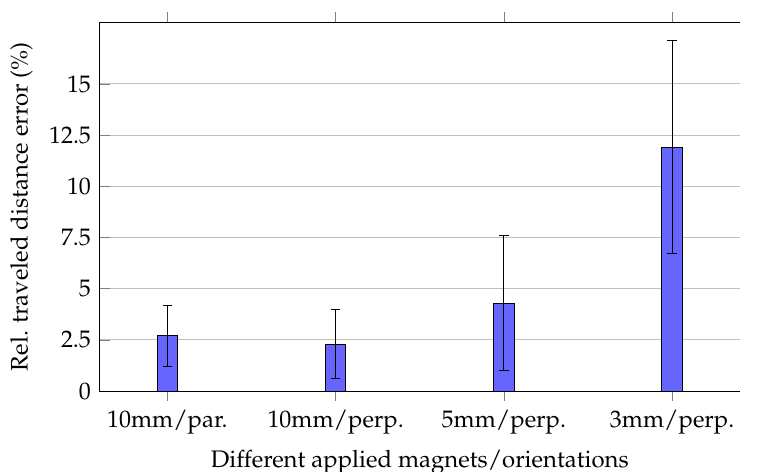
Figure 4. Mean and standard deviation values for relative traveled distance errors for the different magnets and orientations. For the 5mm and 3mm long magnets the cases where the magnetization was parallel with the moving direction were not